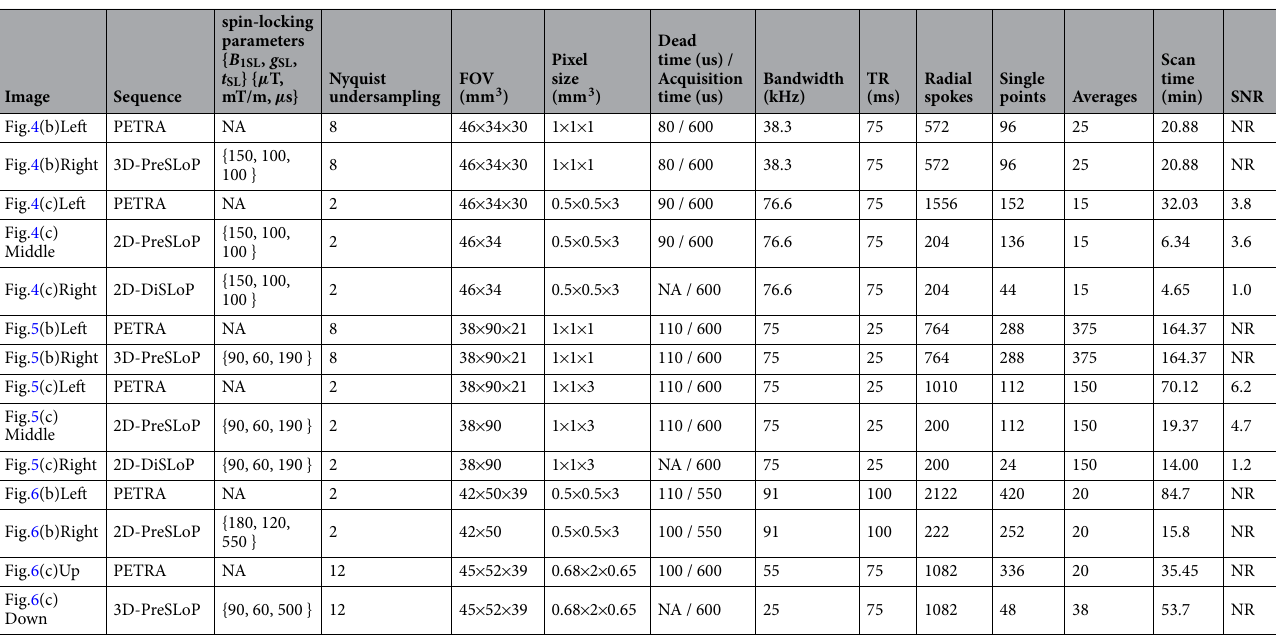
Figure 8. Possible embodiment of PreSLoP where the preservation block includes a CHASE pulse train of length 5, allowing for zero dead time before data acquisition.